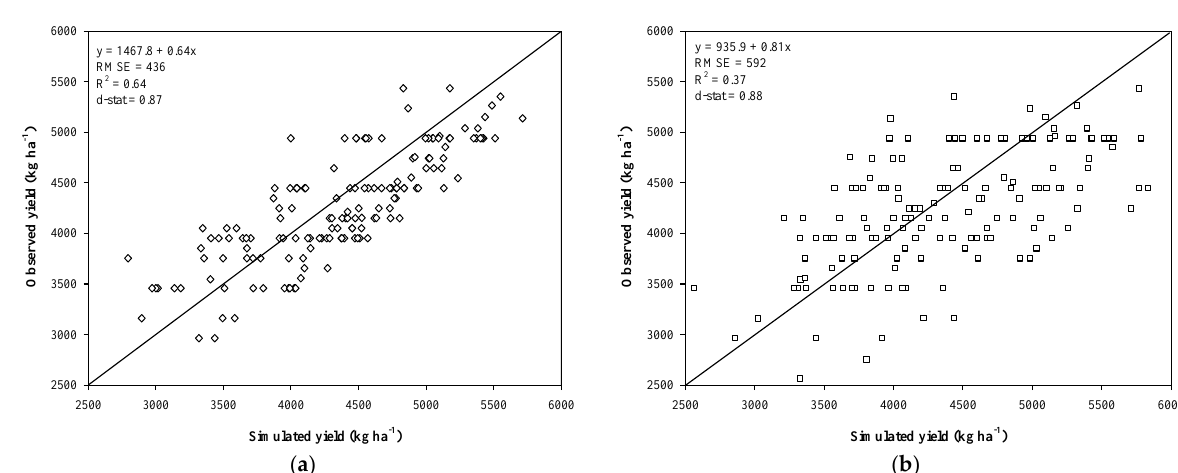
Figure 8. Relationship between observed and simulated yield in 155 farmers’ wheat fields ( a ) using DSSAT (CERES-Wheat), ( b ) using APSIM-Wheat in five strata of the rice - wheat cropping zone of Punjab, Pakistan.